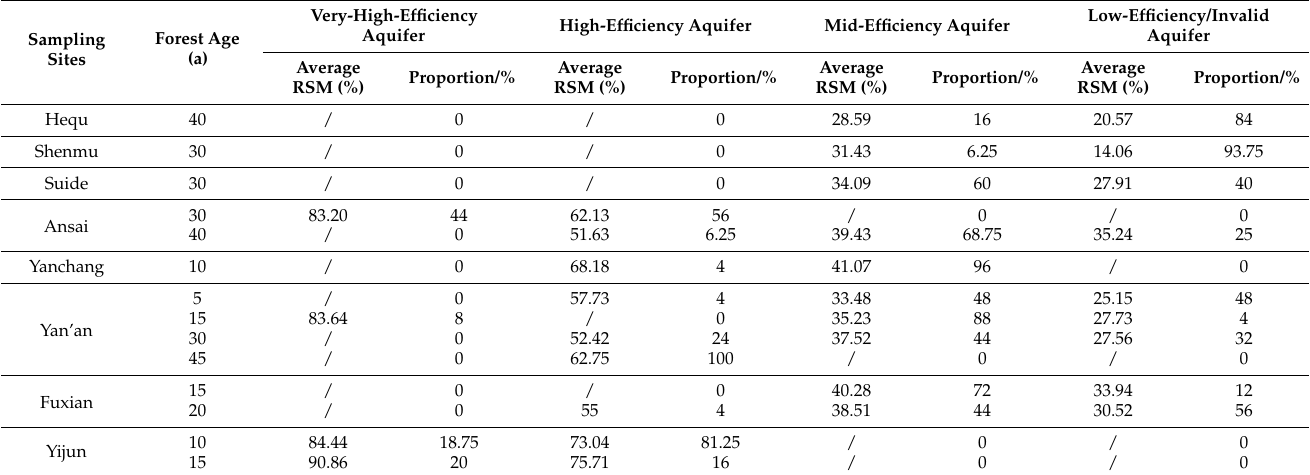
Table 5. Evaluation of soil-moisture availability under R. pseudoacacia forests on the Loess Plateau of